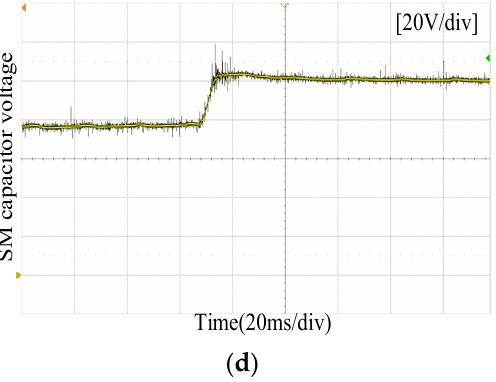
Figure 13. Experimental results of transient process from normal operation to type u failure ( a ) phase u voltage ( b ) line voltage u uv ( c ) current of phase u ( d ) some SM capacitor voltages of phase u and one zoomed-in curve where the voltage ripple is less than 1 V.